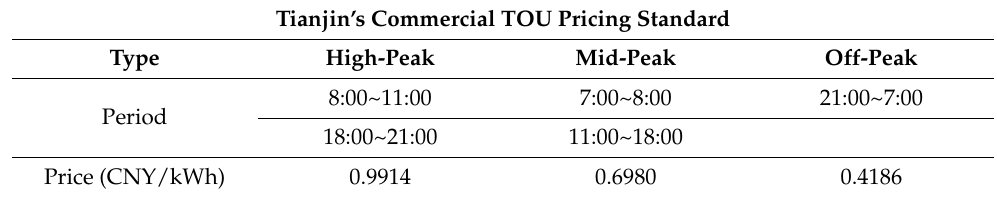
Table 1. Electricity market price for industry during the non-summertime in Tianjin, China. (Source: Tianjin Electricity Price, 2019; www.tj.sgcc.com.cn/) (accessed on 23 June